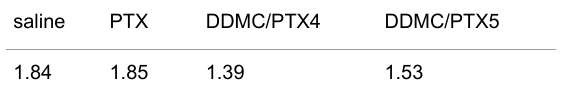
Table 3: Cancer growth ( V / V 0 ) after 48 h from 1st I.P.